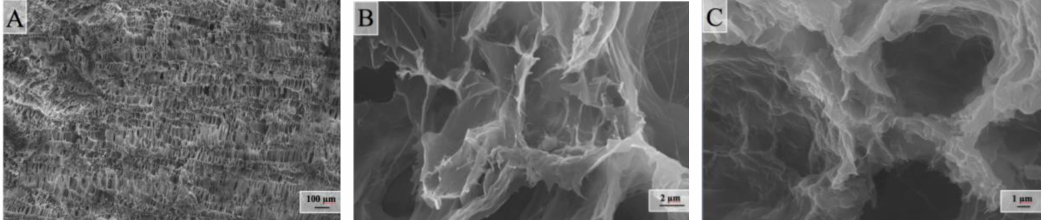
Figure 6. Micrographs of denser sample of composite graphene / MWCNTs aerogel at di ff erent magnifications. ( A ): scale bar 100 µ m; ( B ): scale bar 2 µ m; ( C ): scale bar 1 µ